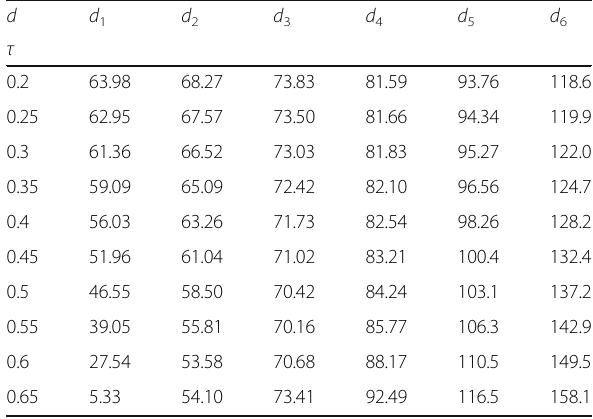
Table 2 The unequal distance of nodes